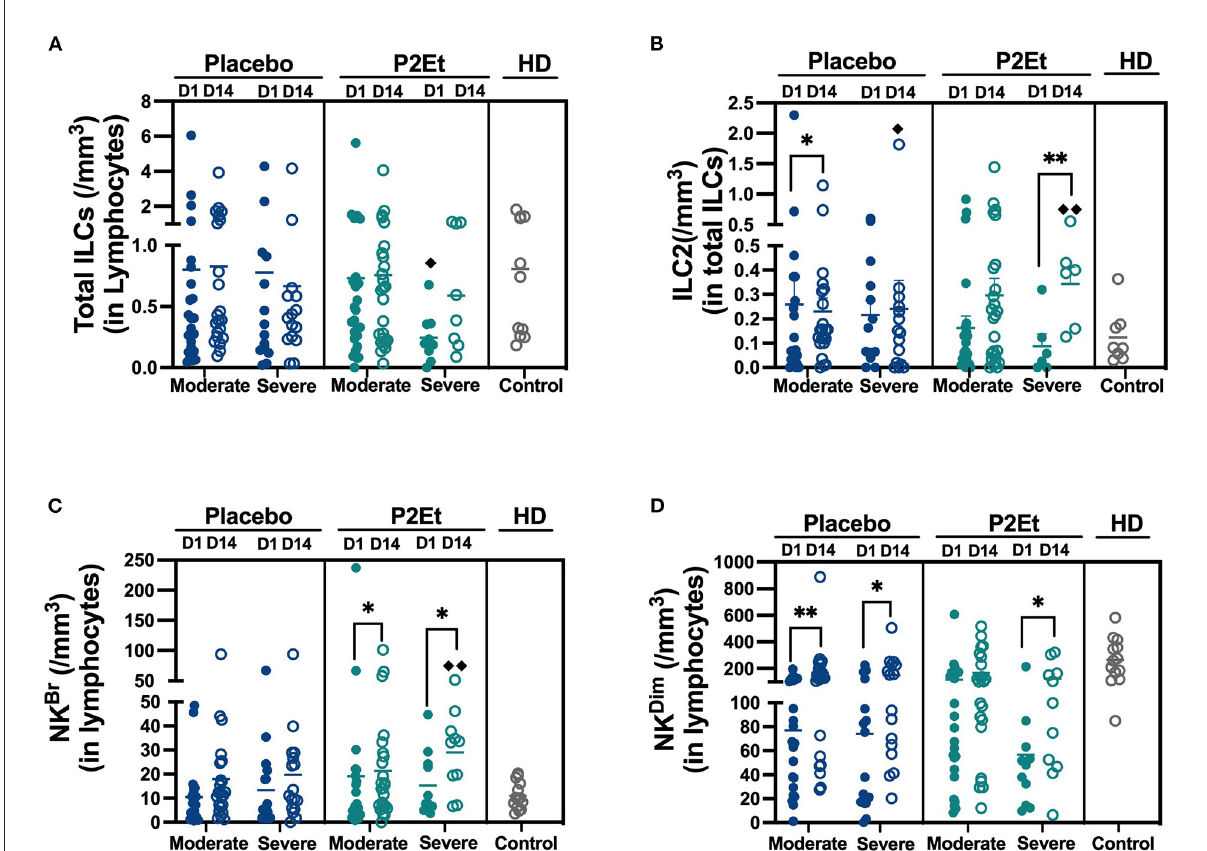
FIGURE2 Absolute counts of Innate lymphocytes cells in the peripheral blood of COVID-19 patients. (A) Absolute counts of total Innate lymphocytes cells (ILCs) in COVID-19 patients (moderate and severe) treated with placebo or P2Et. Healthy donors (HD) were included. (B) Absolute counts of Innate type 2 lymphocytes cells (ILC2s) in COVID-19 patients (moderate and severe) treated with placebo or P2Et. HD were included. (C) Absolute counts of Natural killer Bright cells (NKBr) in COVID-19 patients (moderate and severe) treated with placebo or P2Et. HD were included. (D) Absolute counts of Natural killer Dim cells (NKDim) in COVID-19 patients (moderate and severe) treated with placebo or P2Et. HD were included. Data are represented as the mean ± SEM. The p values between Placebo and P2Et group or within groups were calculated using a Mann-Whitney test. * p < 0.05, ** p < 0.01. The p values between COVID-19 patients and HD were calculated using a Mann-Whitney test. (cid:7) p < 0.05, (cid:7)(cid:7) p <